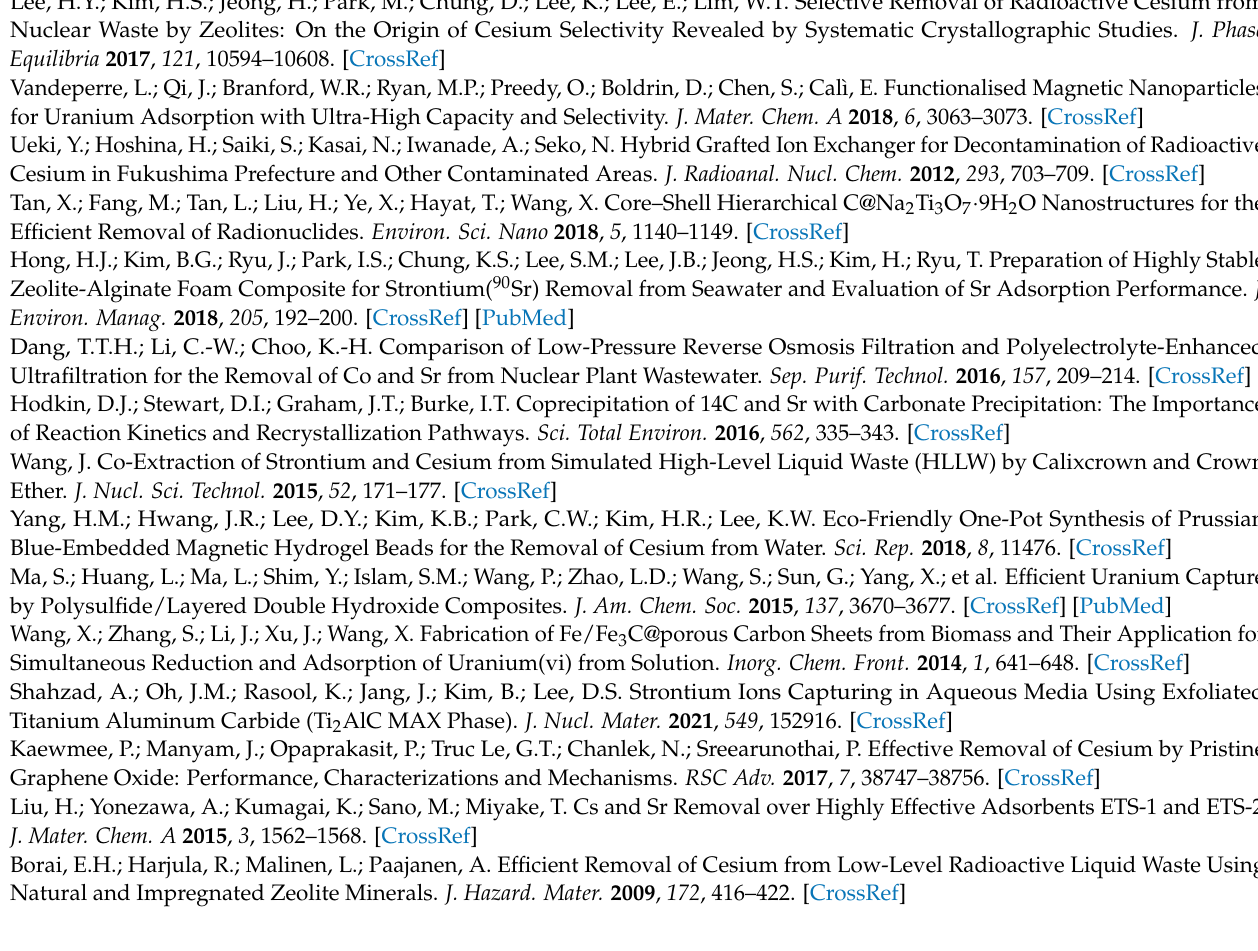
Table S2. Elemental composition of M.Ti 2 CT x .AIII after Sr 2+ and Cs + adsorption, measured in SEM- EDS analysis; Table S3. Elemental composition (Atomic%) of as-prepared M.Ti 2 CT x .AIII and